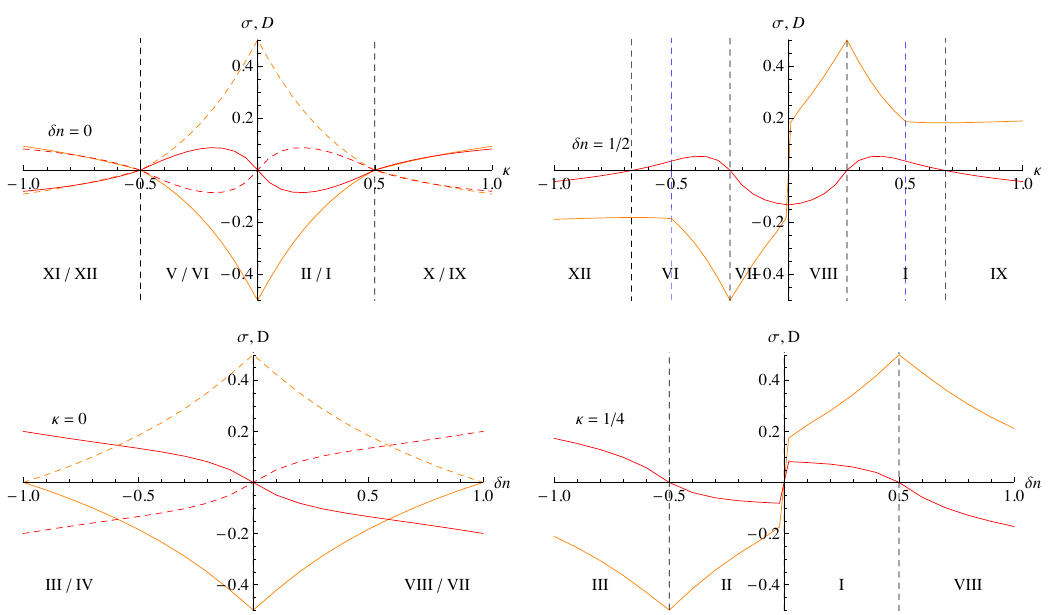
Figure 9 . A horizontal (top) and vertical (bottom) bisection of the density plot in (cid:12)gure 5. We show the values of (cid:27) (orange) and D (red) in the top for (cid:14)n = 0 ; 1 = 2, and in the bottom for (cid:20) = 0 ; 1 = 4. For (cid:14)n = 0 and (cid:20) = 0 there are two saddle point with equal free energy; we plot one of the solutions for (cid:27) and D using dashed curves. Note the several transition points which reproduce the signs of (cid:27) and D shown in the table in (cid:12)gure 5.